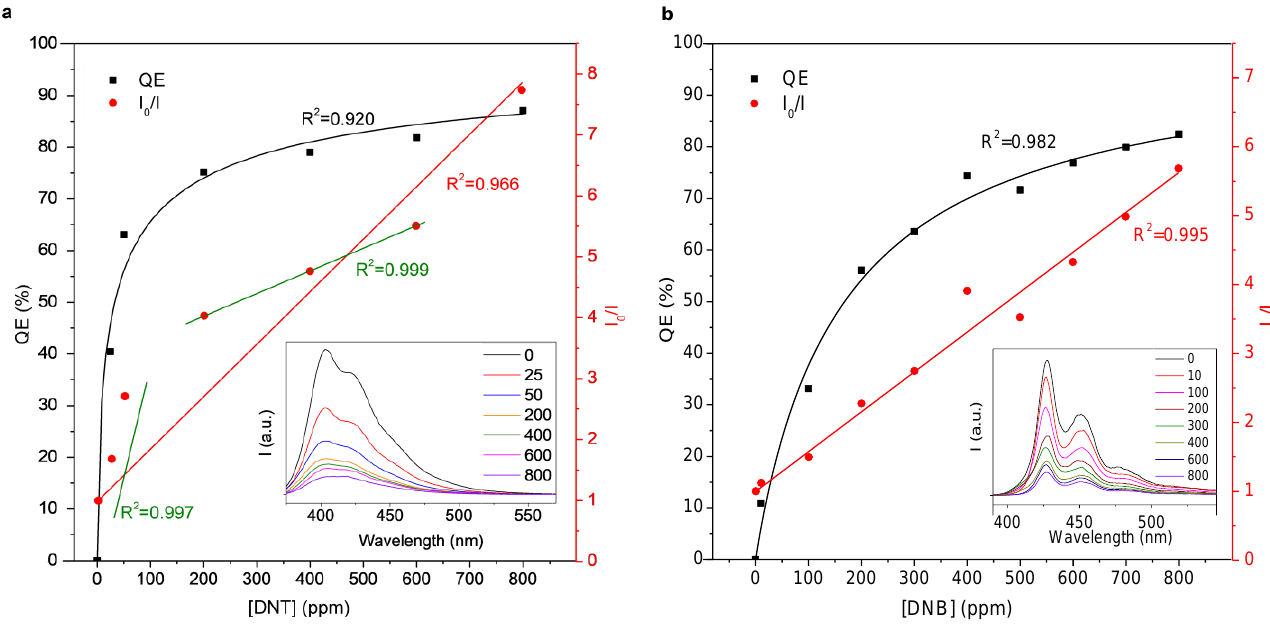
Figure 3. Fluorescence quenching of HTMA-PFP ( a ) and PEDMA-DO-PBF ( b ), in solution, with DNT and o- DNB, respectively, showing both linear fits to I 0 / I (Stern-Volmer plot) and a hyperbolic fit to QE (black), corresponding to the Hill equation. The inset figure displays the emission spectra, under excitation at 375 nm ( a ) or 385 nm ( b ). Legend numbers are expressed in ppm. Table 1. Fitting parameters for the fluorescence quenching of cationic polyfluorenes with nitroaromatics.